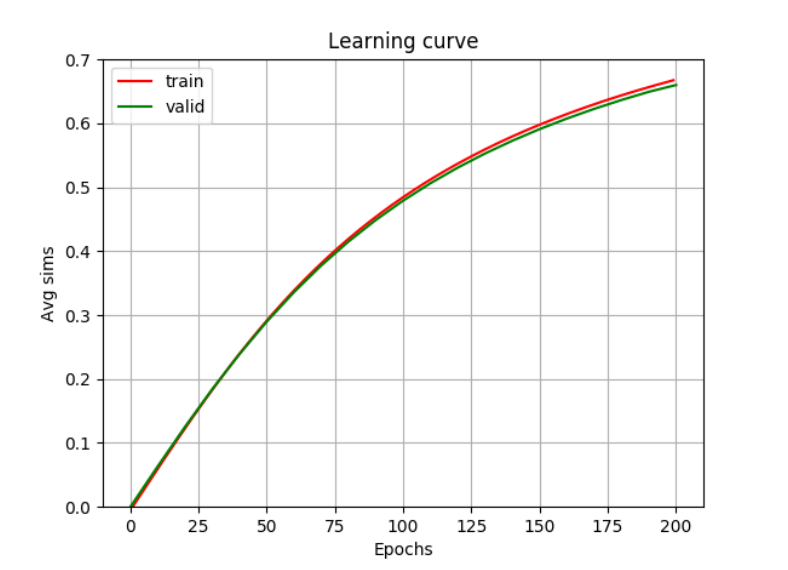
Figure 1. Learning curve of experimenting without using SVD (svd_mode =